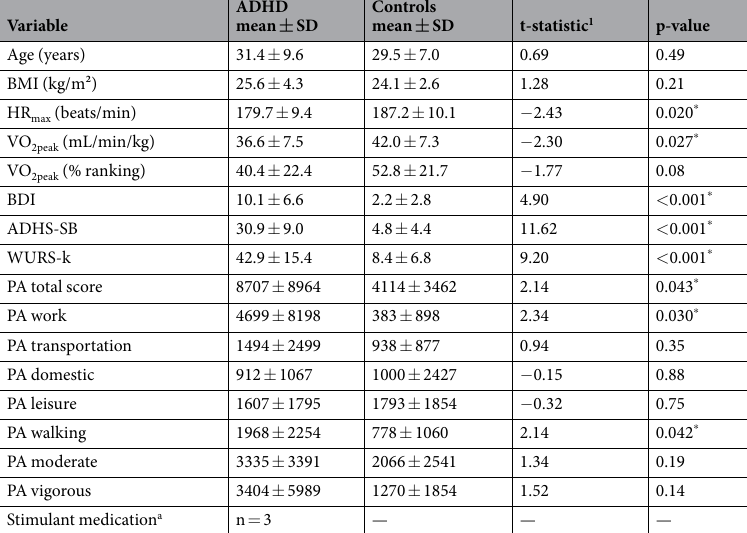
— Table 1. Demographic and clinical characteristics among patients with ADHD and healthy controls. * p < 0.05; 1 two-sample t-test; df = 38. ADHD: N = 20 (3 females); Controls: N = 20 (4 females); SD = standard deviation; rate as assessed by maximal exercise test; VO 2peak (% ranking) = peak oxygen uptake (mL/min/kg) as tested by maximal exercise test transformed into age- and gender-adapted percentiles of healthy people; BDI =